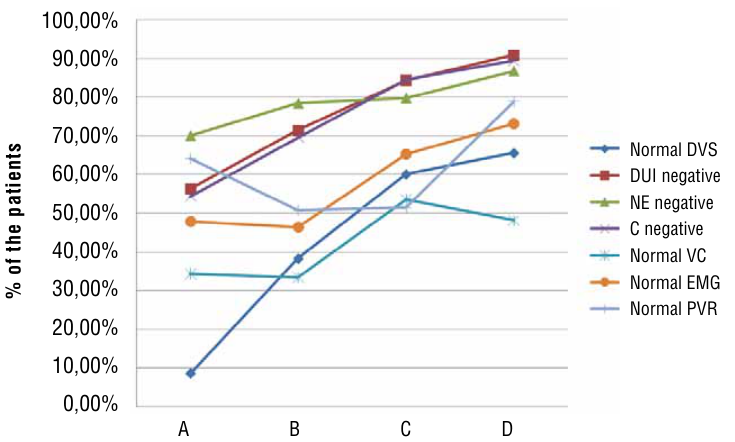
Figure 2 - Primary outcome.